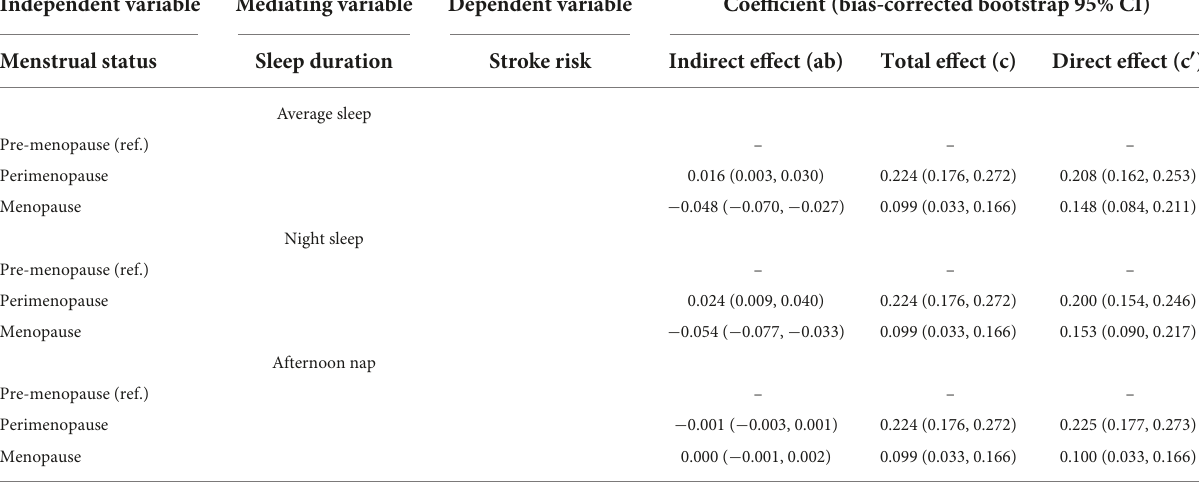
TABLE 4 Mediating effect of sleep duration on the relationship between menopause and stroke risk. Independent